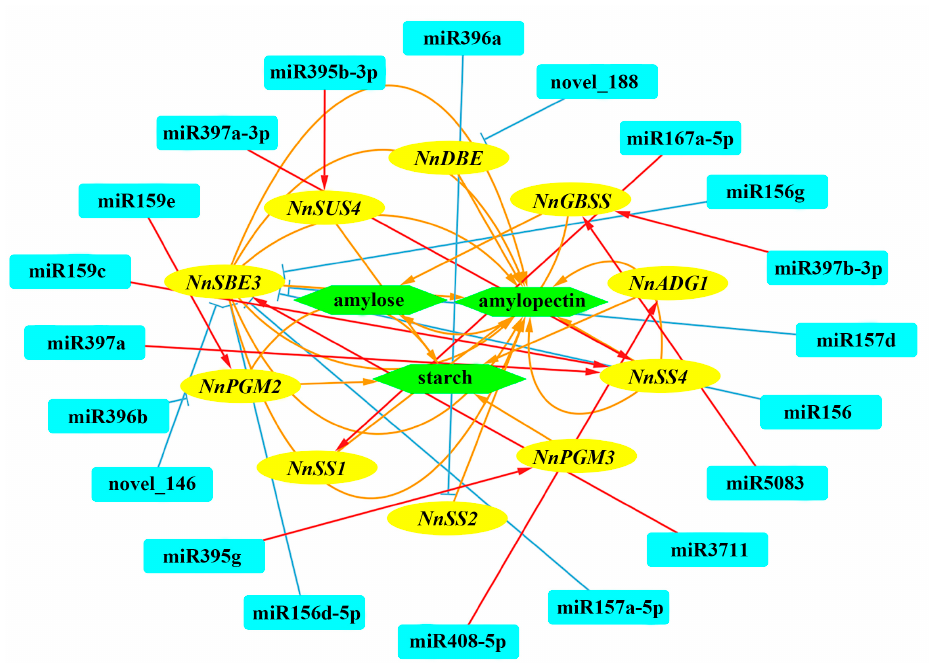
Figure 12. Co-expression network of miRNA-target-starch biosynthesis in different internodes. Blue boxes represent miRNAs, yellow boxes represent target genes, and green boxes represent amylose, amylopectin and total starch.